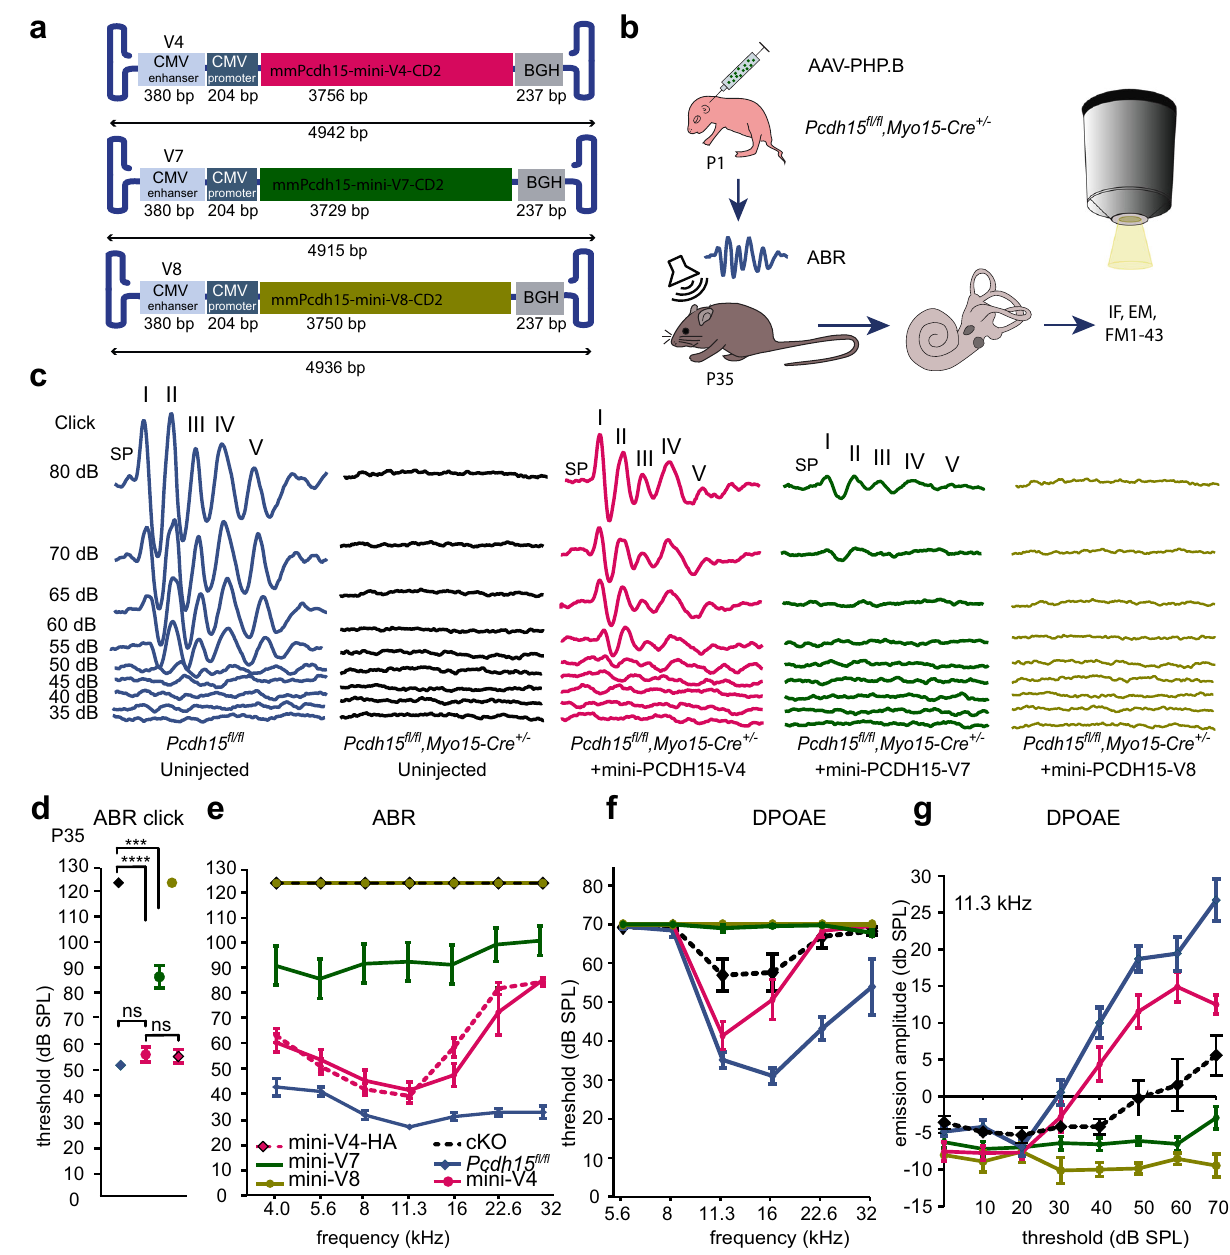
Fig. 4 | AAV-mini-PCDH15s rescue hearing in the Myo15-Cre mouse model of USH1F. a Schematic of the three mini-PCDH15 constructs that are short enough to be packaged into AAV capsids. The lengths of the DNA sequences are shown. VectorsusedaCMVpromoterandBGHpolyadenylationsequencebutnotaWPRE. b AAV9-PHP.B was used to deliver the different mini PCDH15 versions at P1 via round-window membrane injection. IF immuno fl uorescence, EM electron micro- scopy. c Auditorybrainstemresponse(ABR)testingshoweddifferentialrescuewith different AAV-mini-PCDH15 versions. Representative click ABR traces from P35 Pcdh15 fl / fl hearing control mice, from uninjected Pcdh15 fl / fl ,Myo15-Cre +/ − deaf knock- out mice, and from knockout mice injected with AAV-mini-PCDH15-V4, -V7, or -V8. SP, Summating potential. d Average click ABR thresholds for P35 uninjected Pcdh15 fl / fl control mice ( n =4), uninjected Pcdh15 fl / fl ,Myo15-Cre +/ − conditional knockout mice ( n =6), and conditional knockout mice injected with AAV-mini- PCDH15-V4( n =7),AAV-HA-mini-PCDH15-V4( n =14),AAV-mini-PCDH15-V7( n